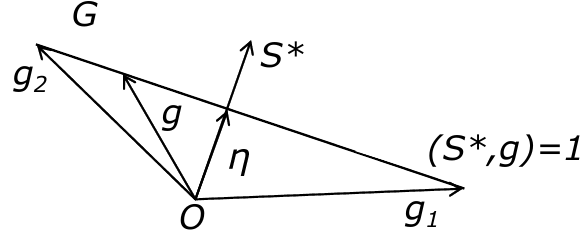
Figure 1. Set G belongs to a hyperplane.